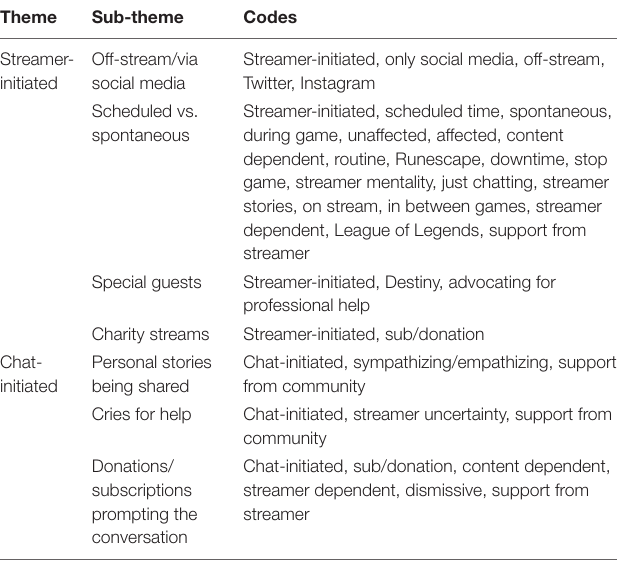
TABLE 2 | Coding breakdown for RQ1: how mental health discussions occur during game streams.